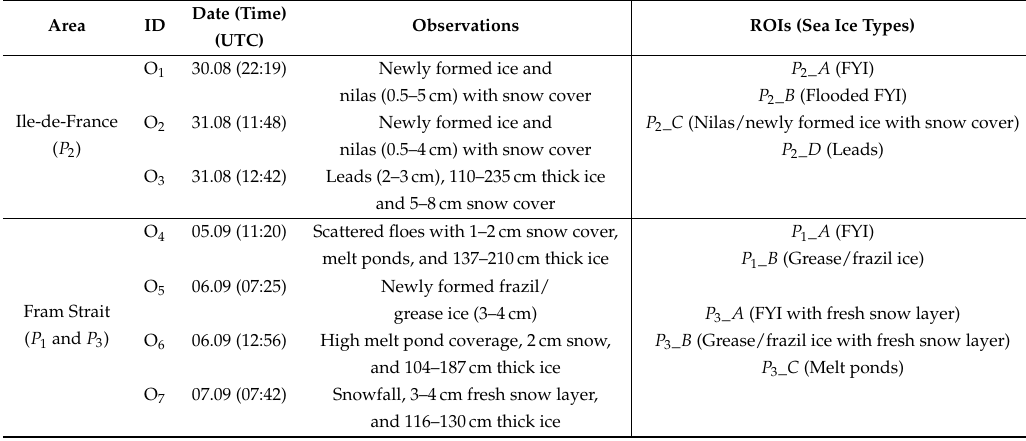
Table 2. Overview of the in-situ observations (indicated by an O symbol) from sea ice stations near R/V Lance from the locations given in Figure 1. The right table shows the labelling of the ice types for the regions of interest (ROIs)